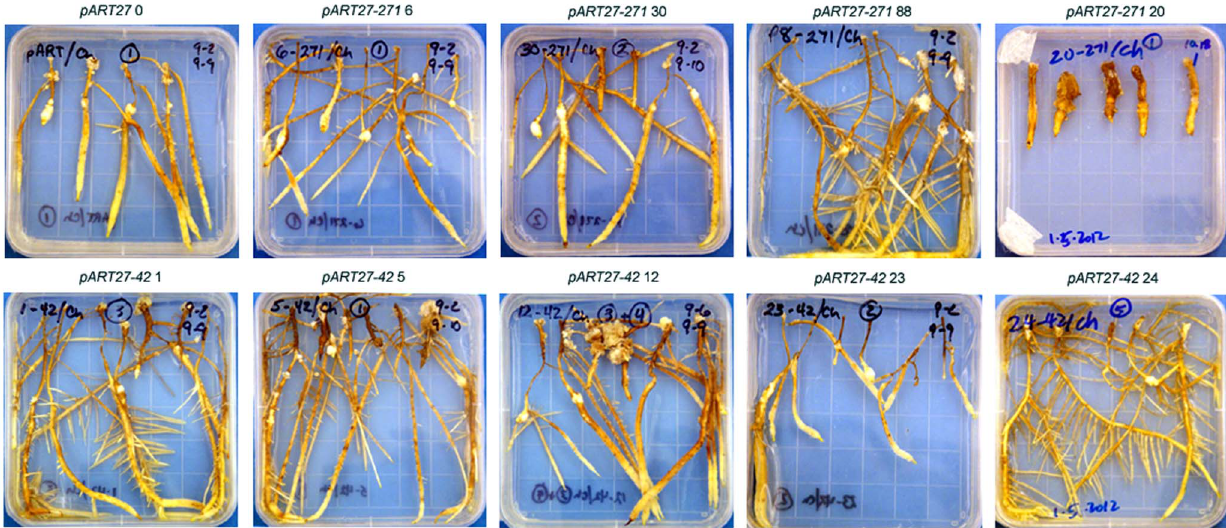
Figure 1. Representative transgenic grape hairy root lines used in this study. Individual hairy root lines carrying a 16D10 RNAi construct, pART27-42 or pART27-271 , were cultured and inoculated with J2 RKNs to evaluate their resistance against RKNs. pART27 0 was a control line which was transformed with an empty binary vector pART27 . Note that pART27-271 line 20 and pART27-42 line 24 showed contrasting variation in their root morphology and proliferation. The pictures were taken three weeks ( pART27-271 line 20 and pART27-42 line 24) or five weeks (the rest) after nematode inoculation.